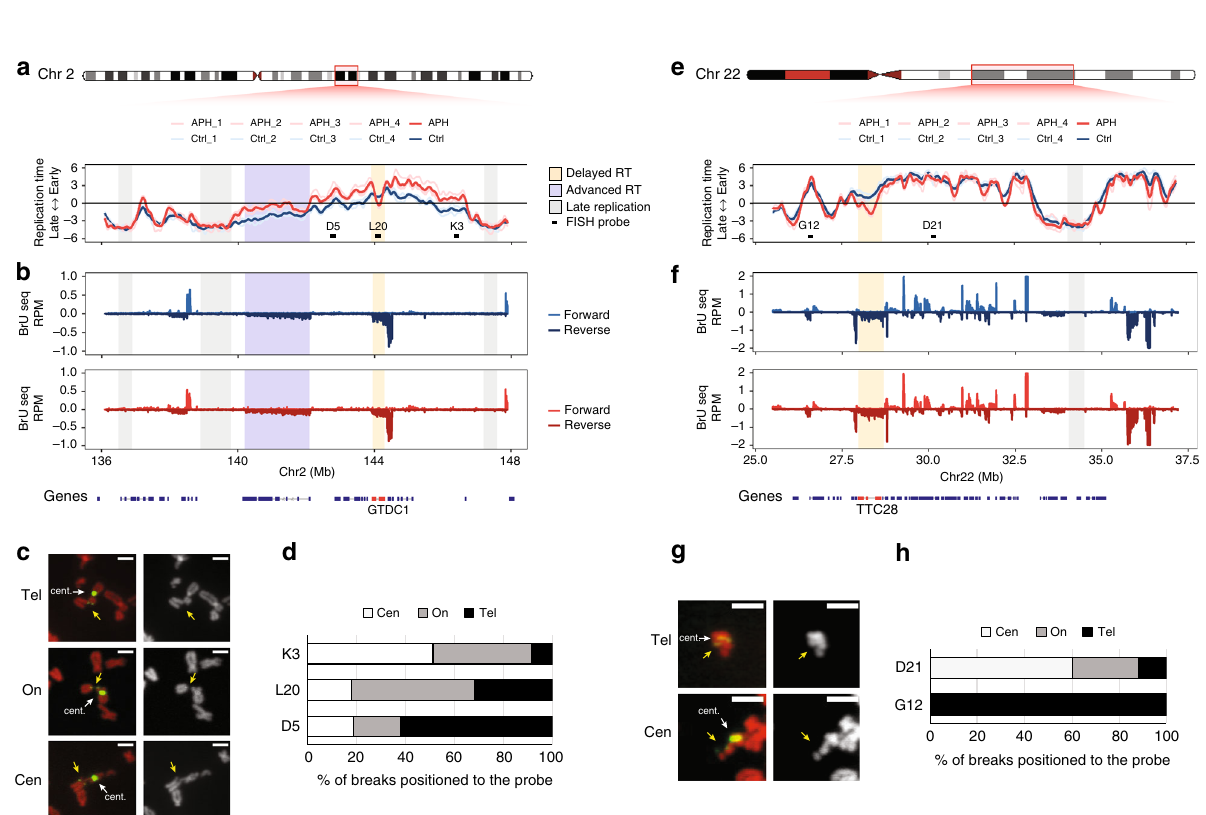
Fig. 1 Aphidicolin affects the RT of speci fi c genomic regions. a Schematic description of Repli-seq. BJ-hTERT cells with ( + ) or without ( − ) APH treatment were pulse labeled with BrdU and sorted into early and late S phase, and the RT programs were obtained by next-generation sequencing. b Correlation matrix of genome-wide RT programs of BJ-hTERT cells with (APH) or without (Ctrl) APH treatment. Four replicates per condition are presented (1 – 4). c Principal component analysis (PCA) of genome-wide RT showing the 1st and 2nd components for control (blue) and APH-treated cells (red). d Identi fi cation of APH-speci fi c RT signatures, distinguishing APH-treated cells (APH) from non-treated control cells (Ctrl). Unsupervised k-means clustering analysis of RT-variable regions identi fi ed speci fi c RT signatures (labeled in gray boxes). The heat map shows the RT ratios [ = log2(early/late)]. e Exemplary RT pro fi les of RT signatures. Numbering according to RT signature in ( d ). The RT pro fi les are displayed as log2 ratios of signals from early and late S-phase fractions. Positive values correspond to early replication, and negative values correspond to late replication. Four replicates per condition are presented color coded according to the legend (Ctrl in blue, APH in red). Yellow boxes mark the RT-variable regions. f Pie chart indicating RT alterations within CFS cytogenetic bands mapped in BJ-hTERT cells following APH treatment.